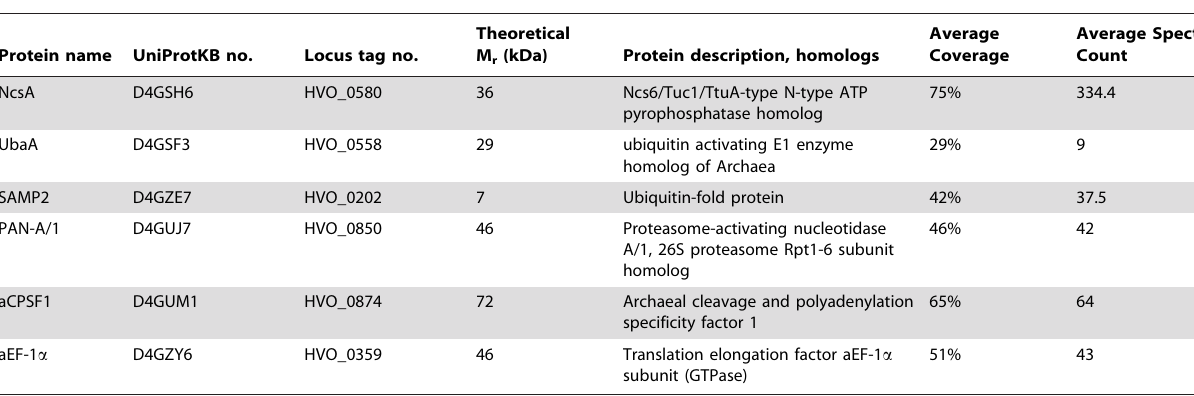
Table 1. Proteins Identified by LC-MS/MS proteomic analysis a .